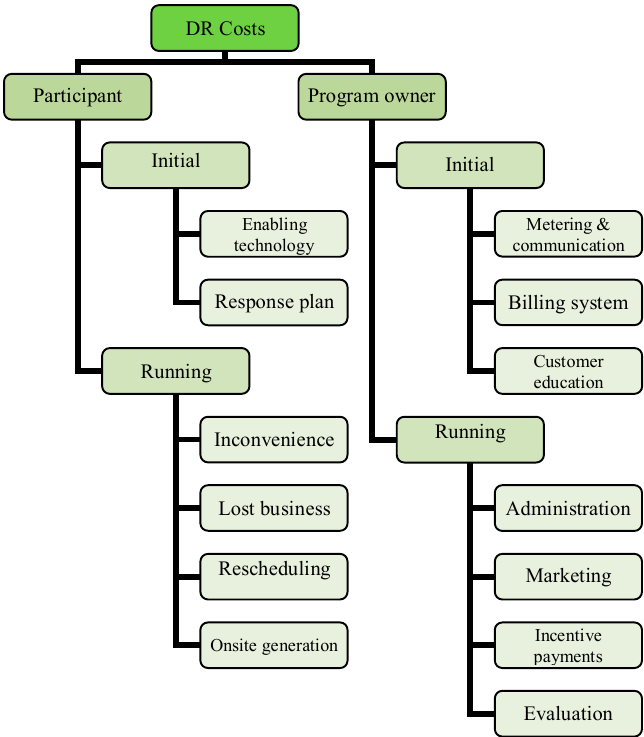
Figure 7. Classification of DR costs [3].